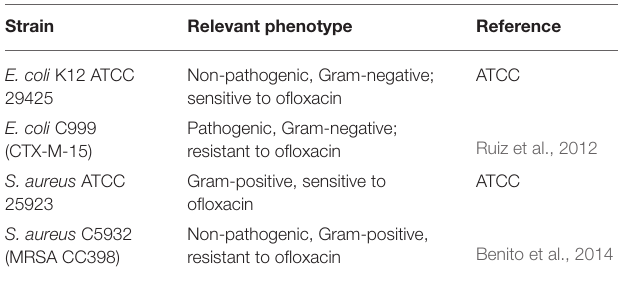
TABLE 3 | BET and BJH porosimetry measurements for Ag@MSNPs (500 µ L TEOS)